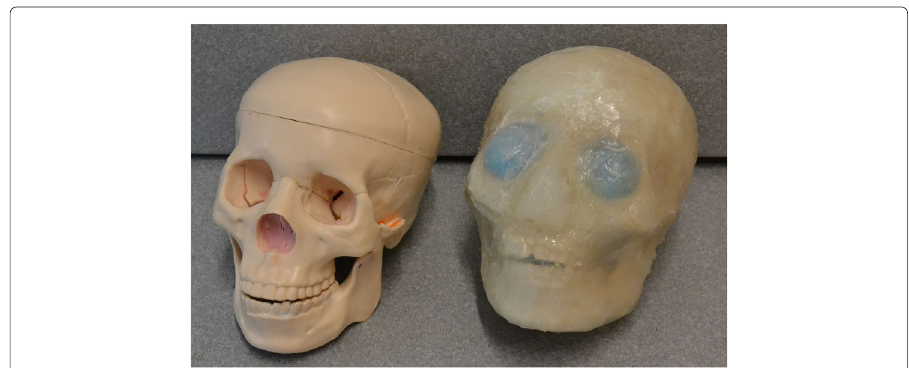
Fig. 1 Commercial skull model (left) which served as a template for creating the bones, and final phantom (right)